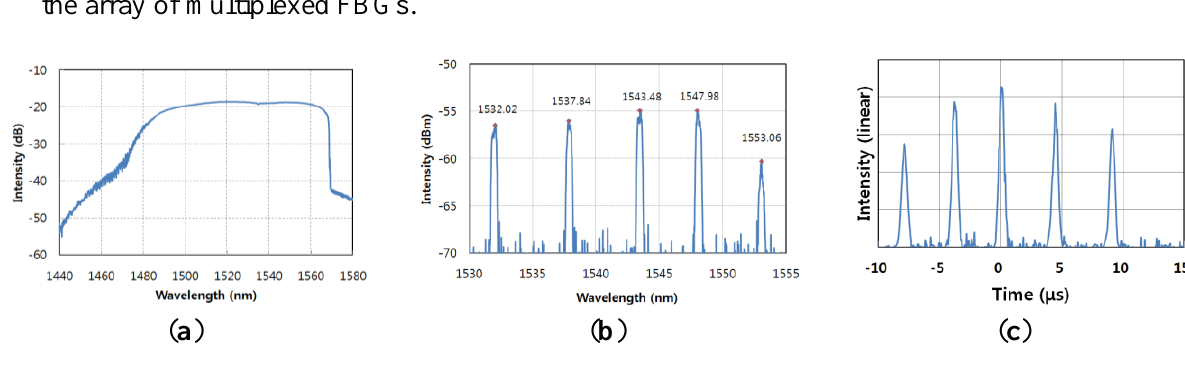
Figure 2. ( a ) Optical spectrum of the WSL; ( b ) optical spectrum of the reflected wavelengths from the multiplexed FBG array; and ( c ) signal of the pulses reflected from the array of multiplexed